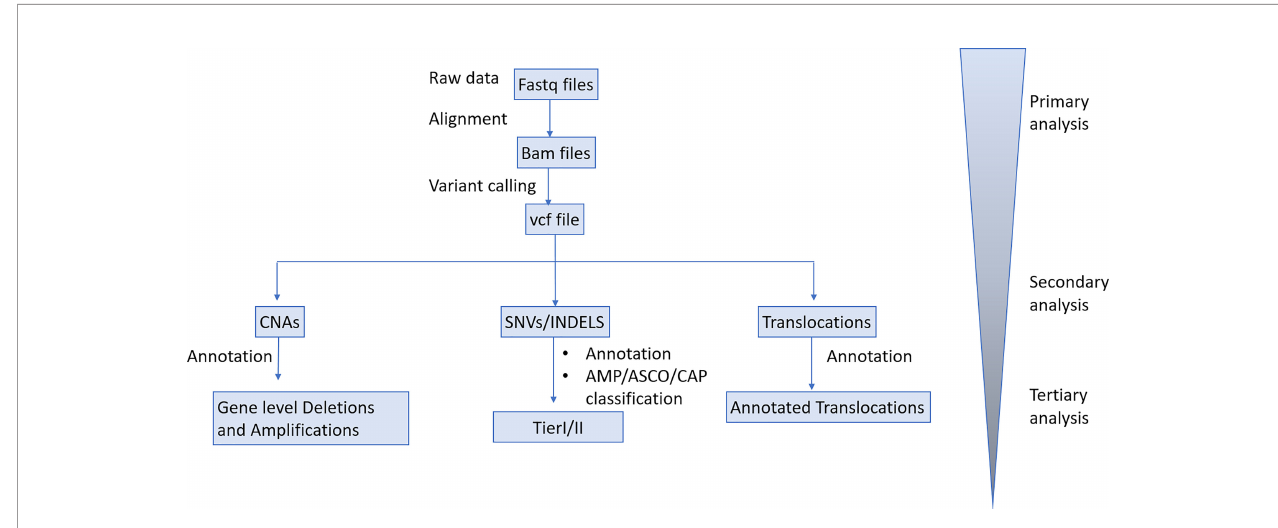
FIGURE 2 | Bioinformatics analysis